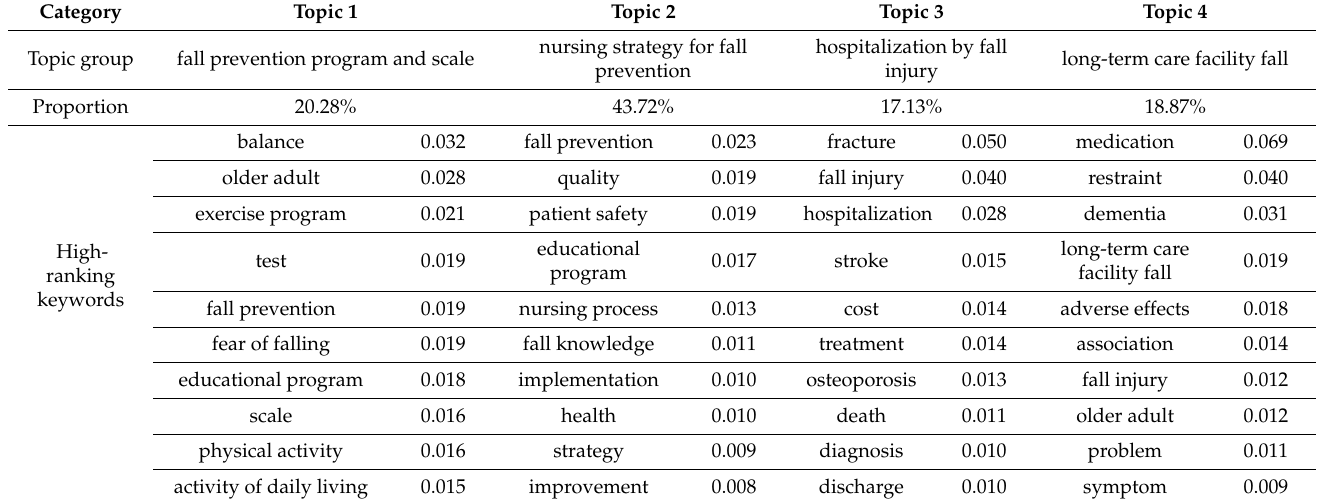
Table 2. Topic group and high-ranking